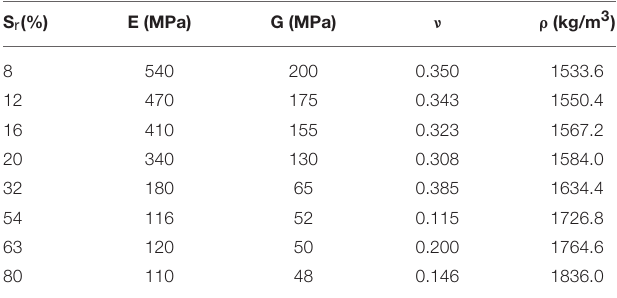
TABLE 1 | Basic properties of silty soil for various saturation